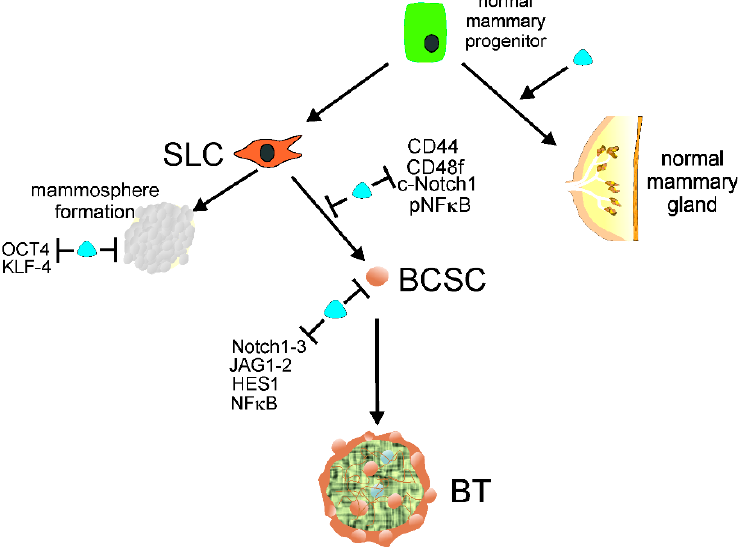
Figure 2. Normal mammary gland progenitors may develop into a normal mammary gland or acquire stem cell-like (SLC) properties to form mammospheres or/and transform into breast cancer stem cells (BCSCs). 1,25(OH)2D, a biologically active metabolite of vitamin D, along with its receptor, VDR, symbolized here as a blue tear, supports the normal development of mammary gland and prevents mammosphere formation by repressing the pluripotency markers OCT4 and KLF-4. Vitamin D may also prevent the conversion of SLC cells into BCSCs by downregulation of other pluripotency markers, including CD44, CD49f, c-Notch1, and pNF κ B. Vitamin D may also repress proteins needed for the maintenance of BCSCs, such as Notch1-3, JAG1-2, HES1, and NF κ B, preventing the initiation and formation of breast tumors (BTs). Abbreviations are defined in the main text.